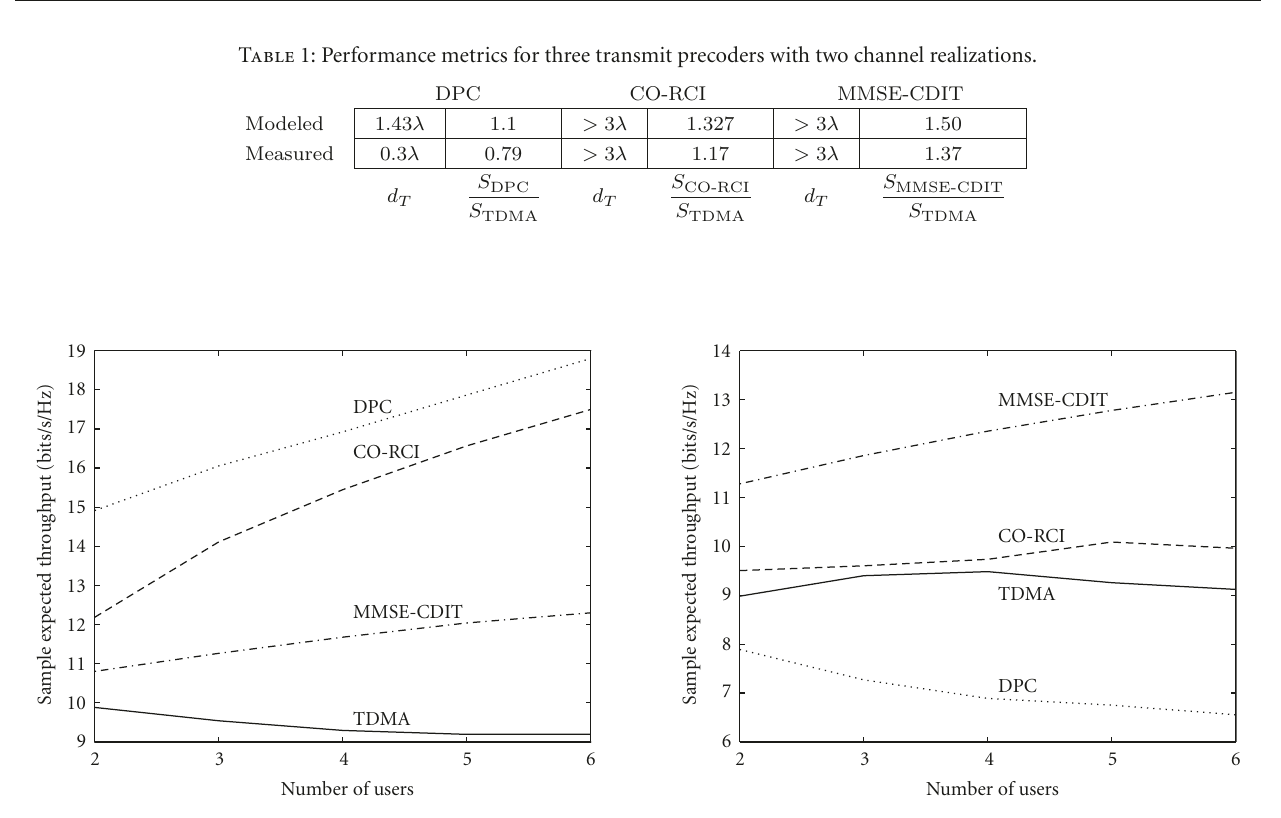
Figure 8: Sample expected throughput versus number of users for N t = N r = 4 and P = 10 in the measured channel. There is a lag of 1 . 5 λ between channel acquisition and